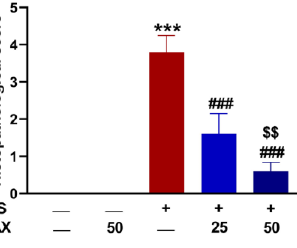
Figure 3. Histopathological scores of kidney sections of mice. TAX decreased kidney injury score in CIS-intoxicated mice. Data are mean ± SEM. *** p < 0.001 versus Control, ### p < 0.001 versus CIS, and $$ p < 0.001 versus TAX (25 mg/kg).